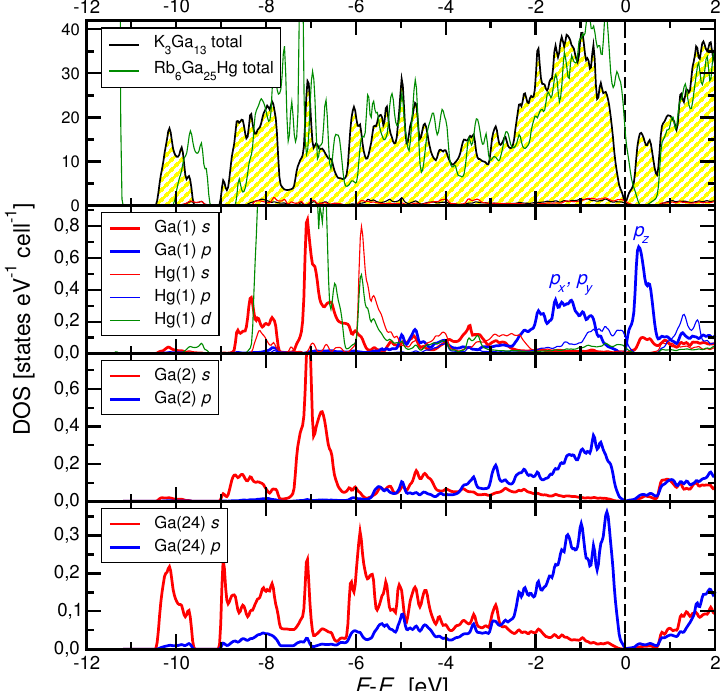
, together 7 In” (thin lines). 6